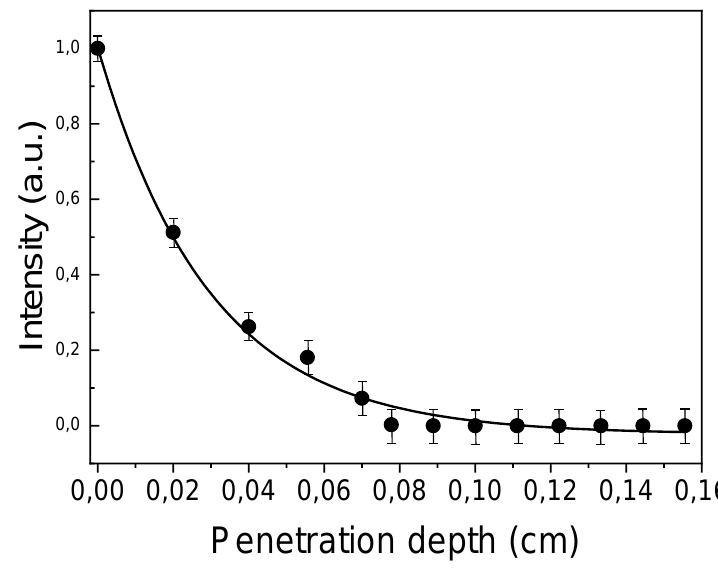
Figure 4. Normalized intensity of the upconversion emission at 800 nm, generated by Tm,Yb:GdVO 4 @SiO 2 core-shell nanoparticles in a 2% intralipid aqueous solution to respect the intensity value measured at the surface of the phantom tissue as a function of the penetration depth (continuous line was done for guiding the eyes).